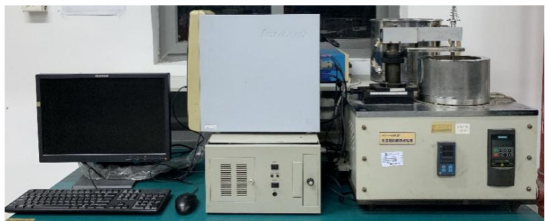
Figure 6. HT-500 high temperature friction and wear tester.